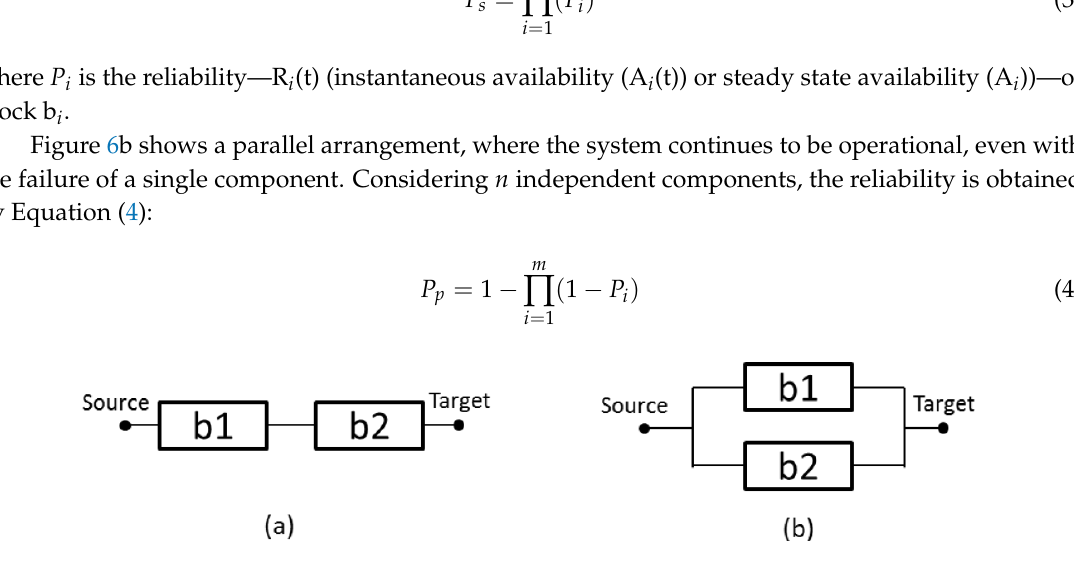
Figure 6. ( a ) Serial arrangement; and ( b ) parallel